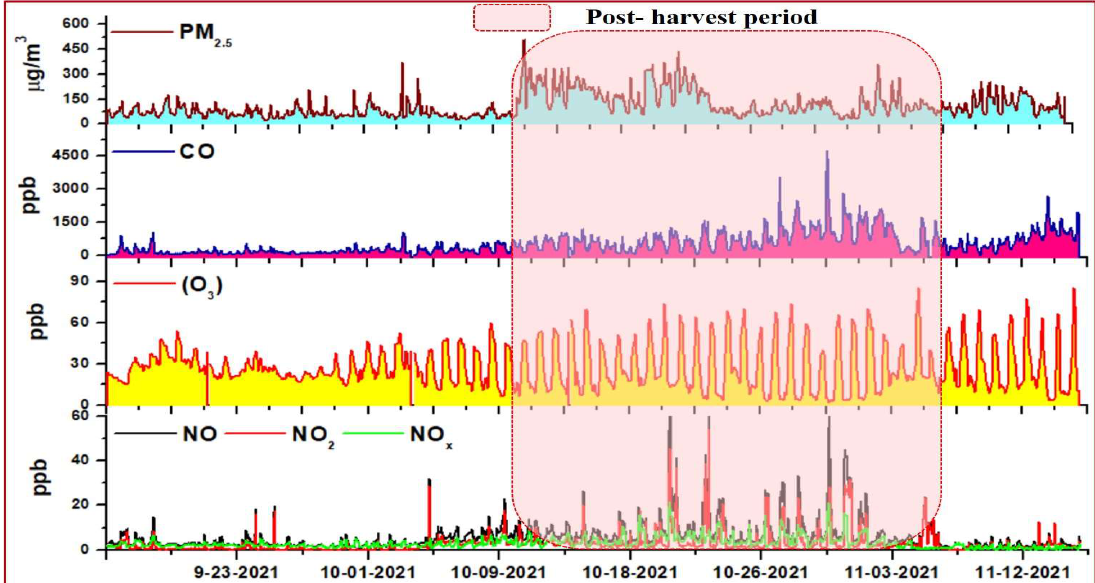
Figure 2. Day-to-day variability of PM and trace gases during the pre-harvest and post-harvest pe- riods.